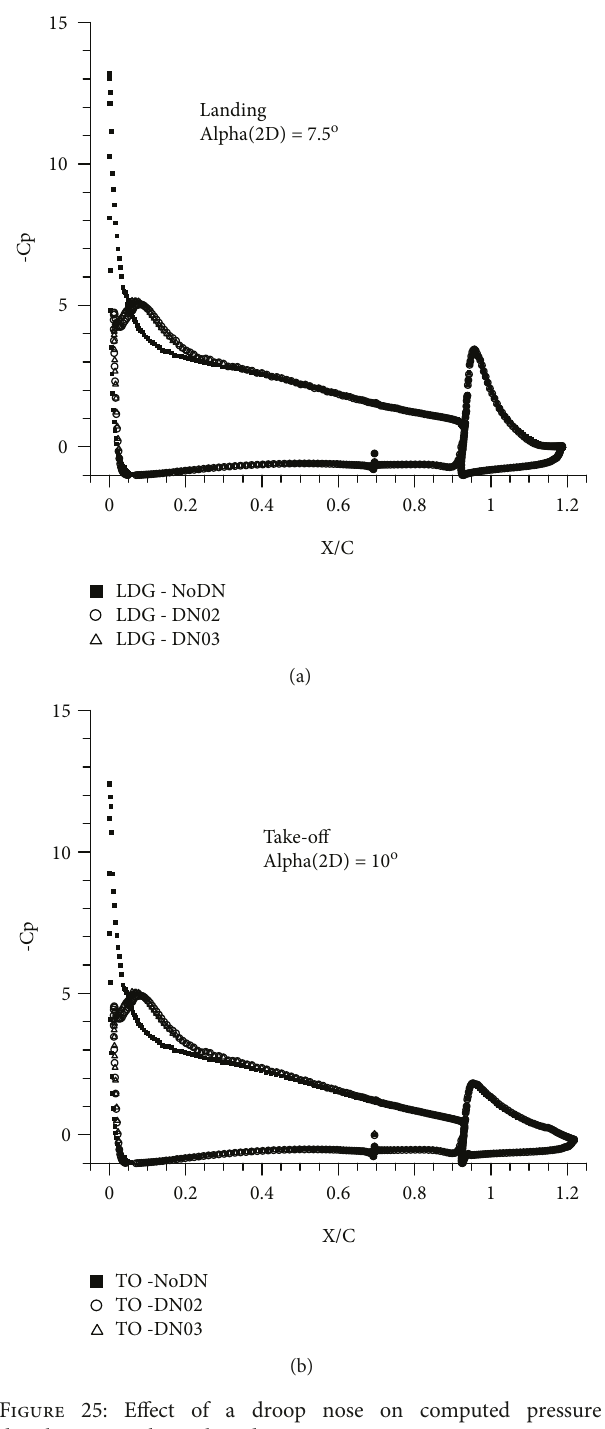
Figure 25: E ff ect of a droop nose on computed pressure distributions at the outboard wing section.